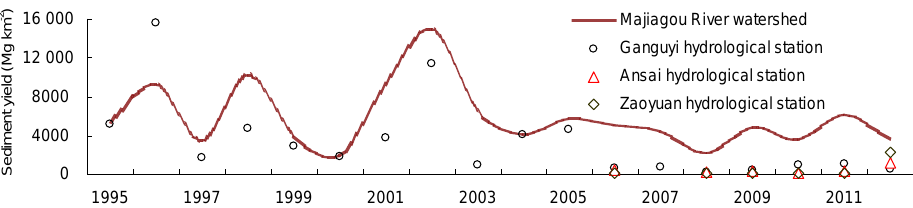
Figure 5. Validation of the sediment yield modulus among Ganguyi, Ansai, and Zaoyuan hydrological stations and the Majiagou River watershed based on the originally established model.